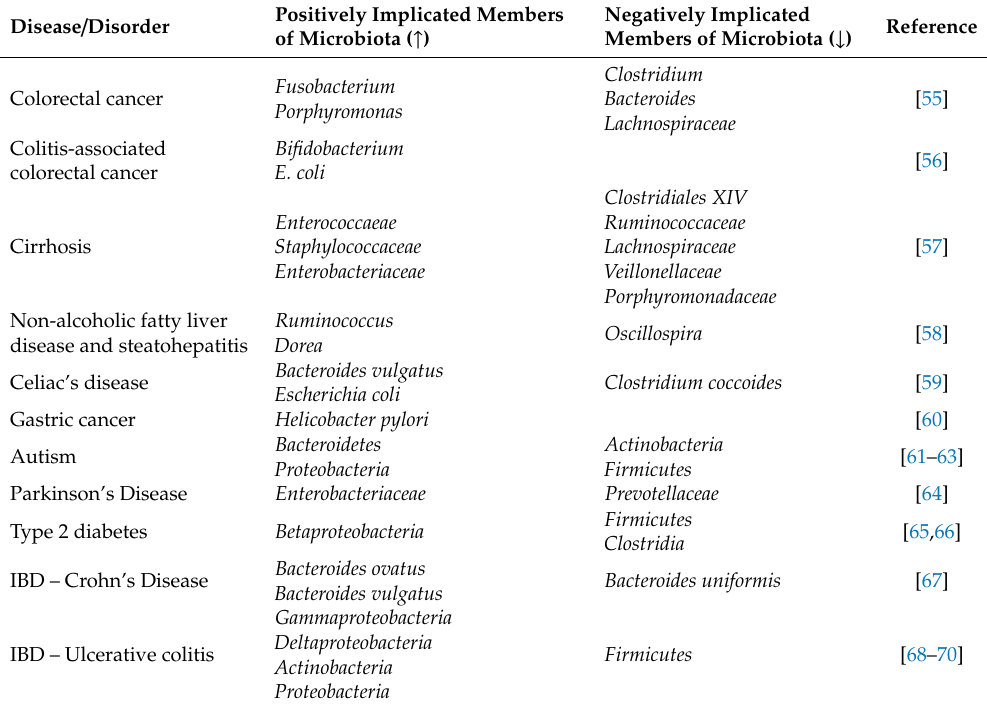
Table 1. Changes in the gut microbiome associated with disorder /